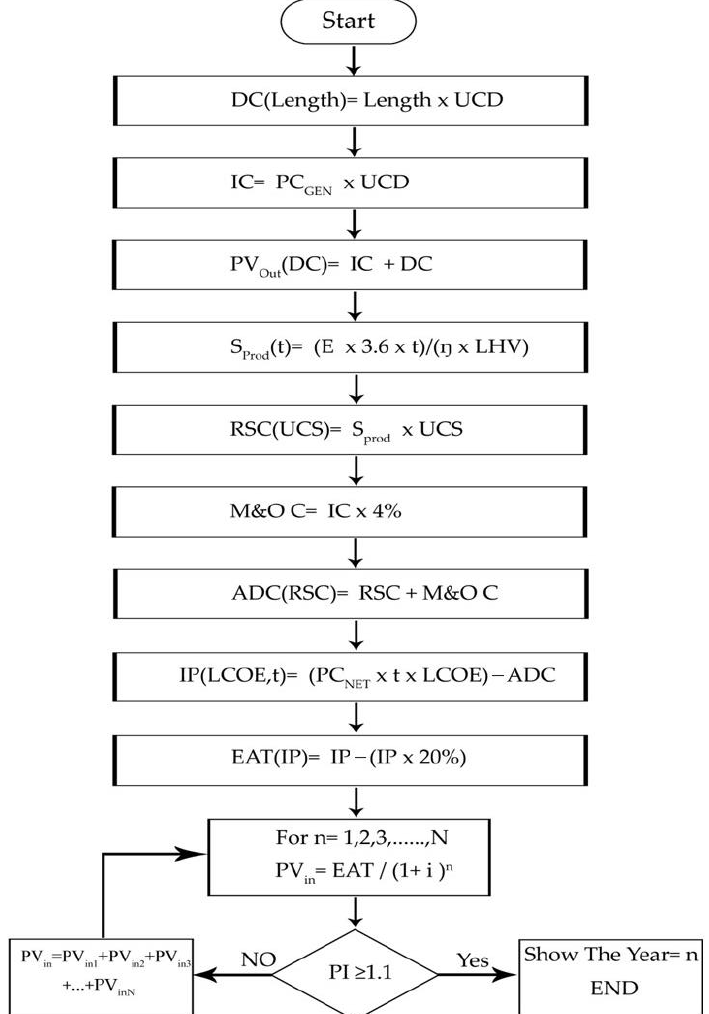
Figure 3. Algorithm for the calculation of the profitability index.